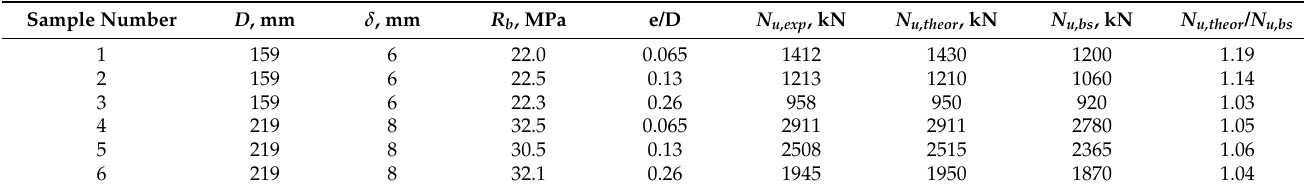
Table 2. Comparison of experimental results with theoretical values of ultimate loads.